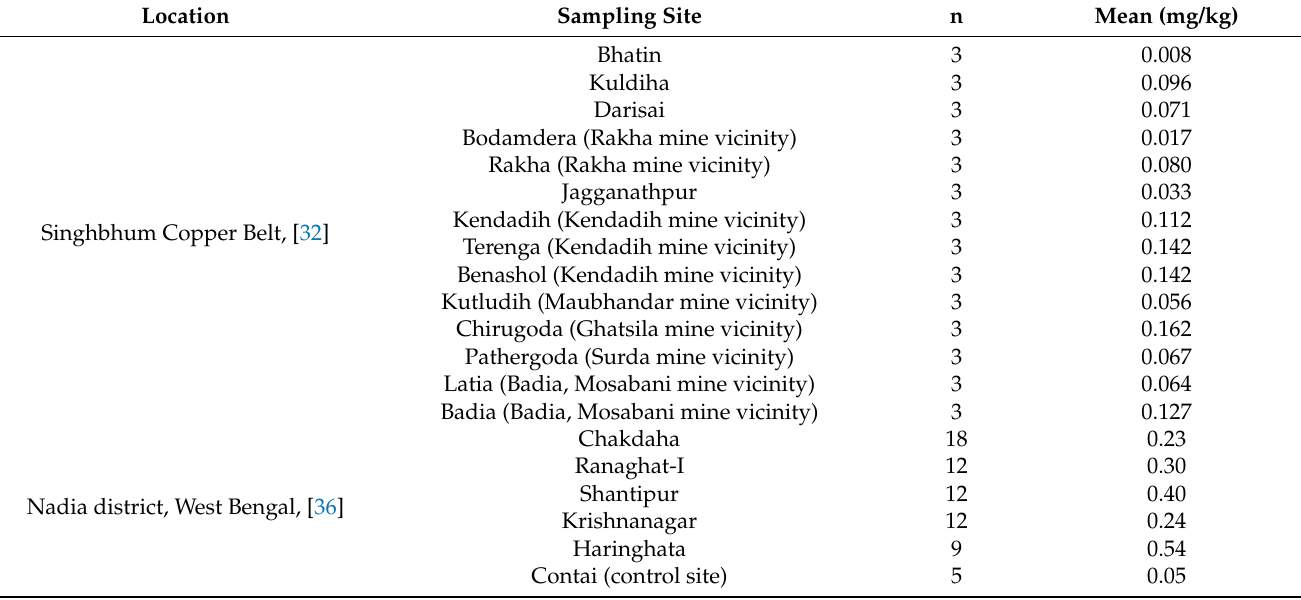
Table 2. Total arsenic concentration in rice sampled from mining areas in India and the West Bengal region.